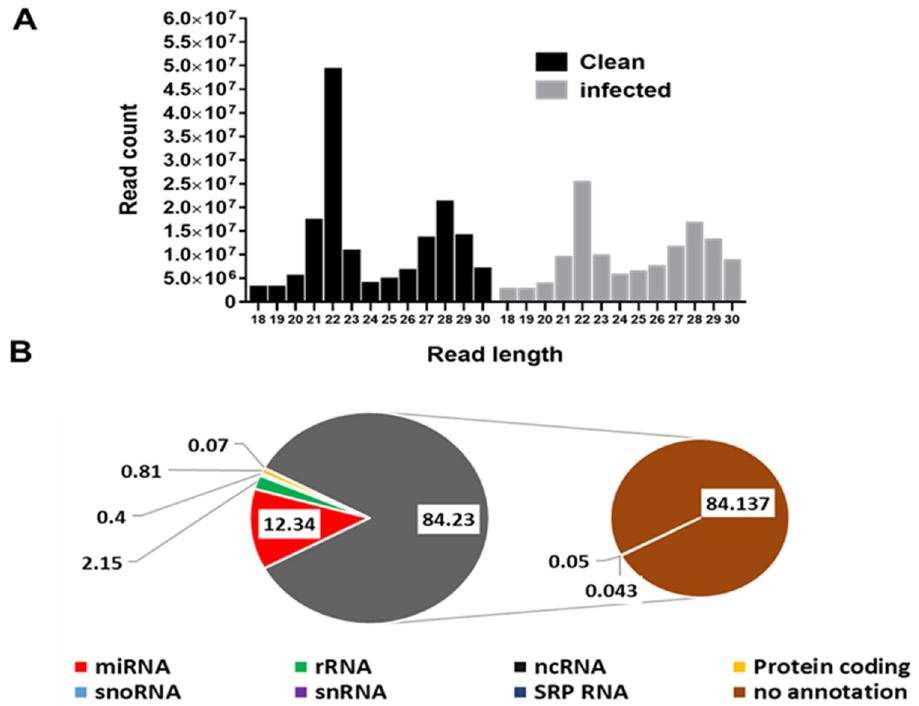
Figure 1. ( A ) Small RNA sequence length distribution in uninfected (clean) and Borrelia-burgdorferi - infected Ixodes scapularis salivary glands. MicroRNAs are twenty-two (22) nucleotides in length. Clean, uninfected salivary glands; infected, Borrelia-burgdorferi -infected salivary glands. ( B ) Summary of the abundance of combined small RNA reads from Ixodes scapularis salivary glands matching various small RNA categories. Reads from uninfected and Borrelia-burgdorferi -infected samples are combined together for abundance calculation.